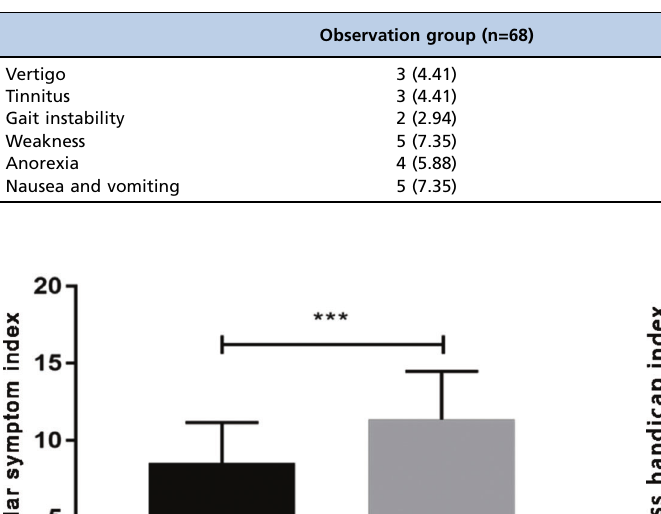
Table 5 - Adverse reactions after treatment [n (%)].